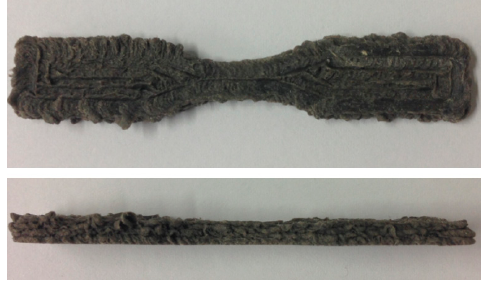
Figure 8. Asymmetrical surface finish of a 30 wt % harakeke dog bone specimen.